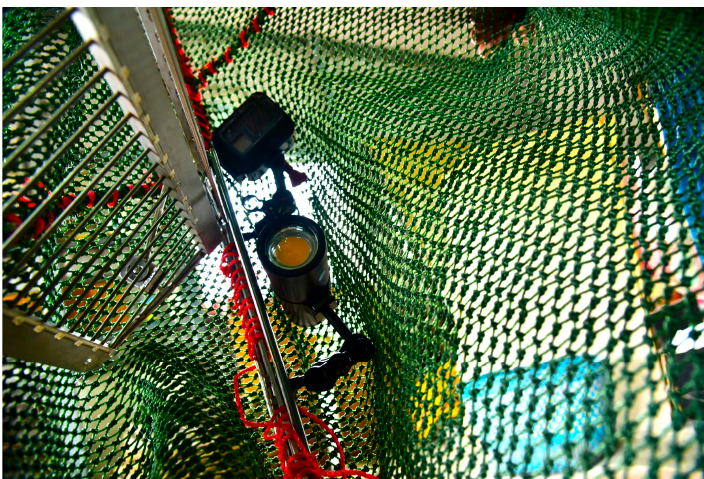
Figure 6. Underwater photography system for measuring JTED performance.